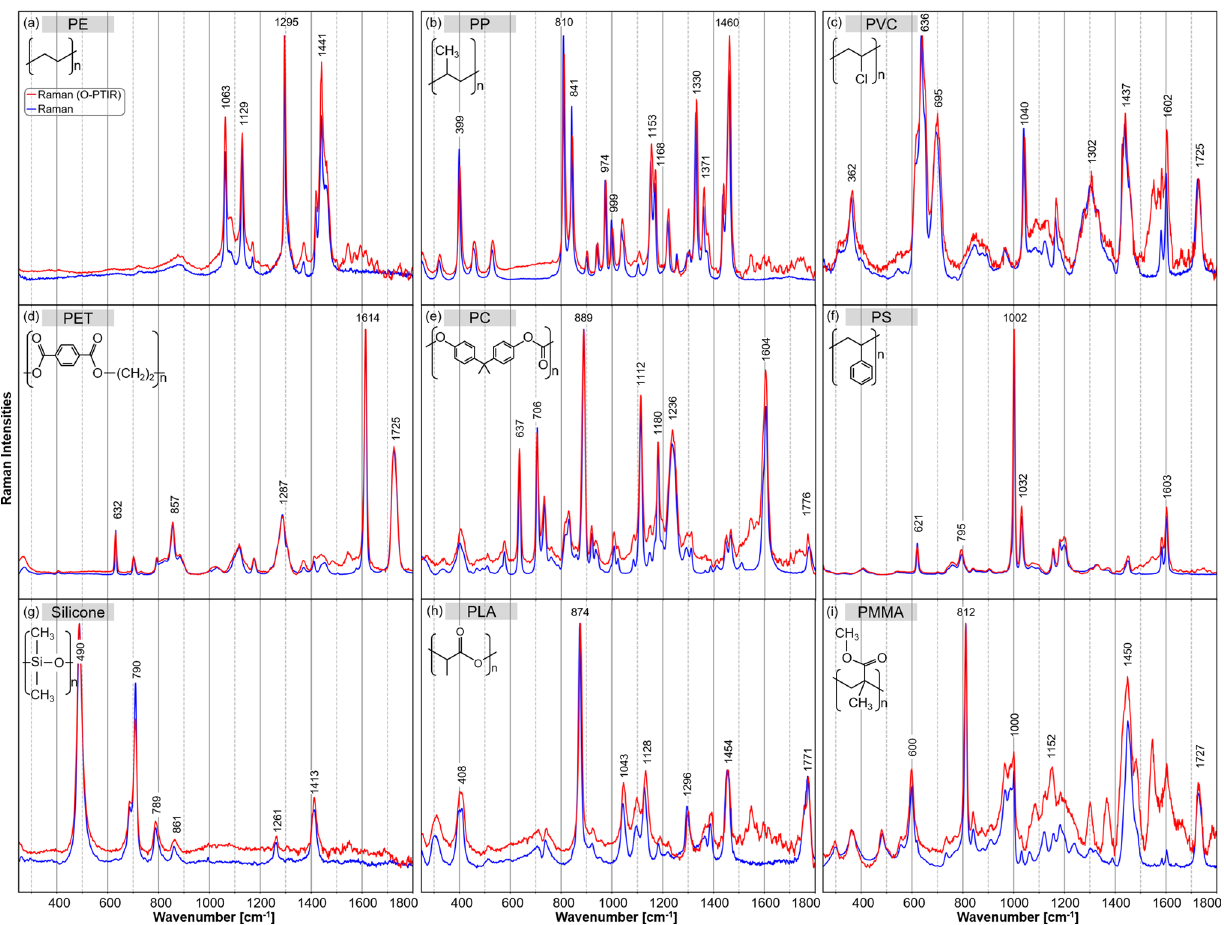
polypropylene (PP) ( b ), polyvinyl chloride (PVC) ( c ), polyethylene terephthalate (PET) ( d ), polycarbonate (PC) ( e ), polystyrene (PS) ( f ), silicone ( g ), polylactide acid (PLA) (h) and polymethylmethacrylate (PMMA) ( i ) collected with the standalone Raman system (blue) and the simultaneous Raman option of the O-PTIR instrument